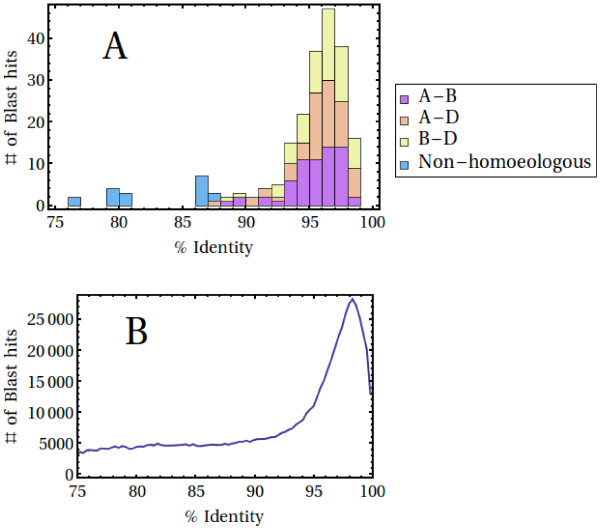
Sequence similarity of assembled contigs compared to those of the OM sequence set. Similarities between homoeologs from the OM set (Panel A) are all between 87 and 99%, while similarities between a small set of genes not classified as homoeologs in Ogihara et al. [25] and Mochida et al. [18] exhibit a somewhat smaller sequence identity. Sequence similarities between assembled contigs (Panel B) were quantified from an all-vs-all BlastN search (E-value < 10-50, alignment length >400 bp). A sharp rise at a %ID at around 93% is clearly visible. Note that a maximum of one Blast hit per sequence pair has been retained in order to produce this plot.